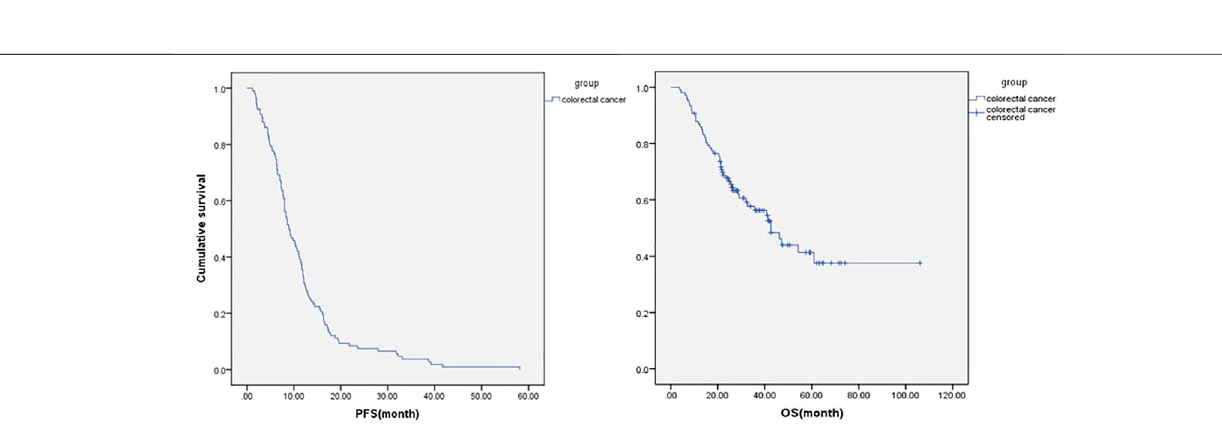
Frontiers in Pharmacology |